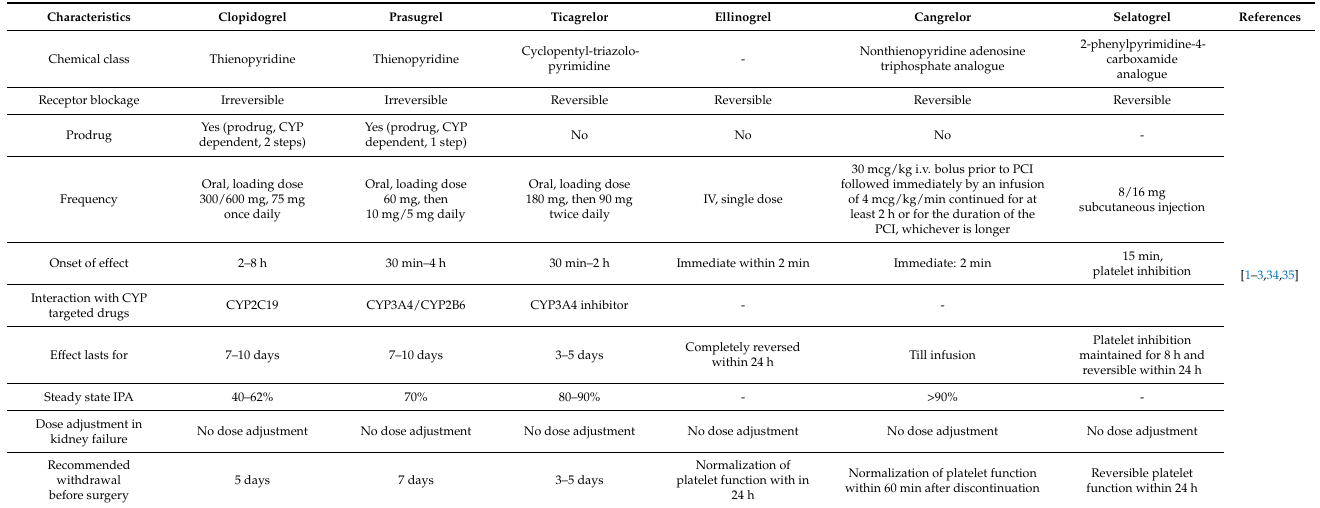
Table 3. Comparison of pharmacological characteristics of major P2Y12 receptor